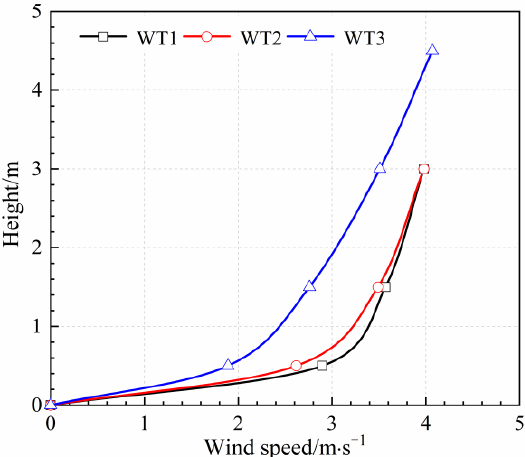
Figure 4. Mean annual wind speed at different heights of the three wind-towers.